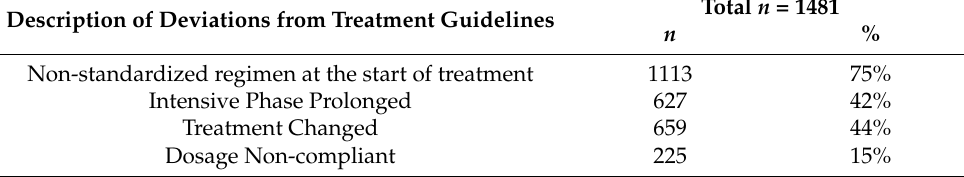
Table 2. Compliance characteristics of MDR/RR-TB patients registered from 2012 to 2018 in Uzbek- istan and assessed under the project of “Evaluation of the TB drug usage for treating MDR TB” (Intensive Phase).